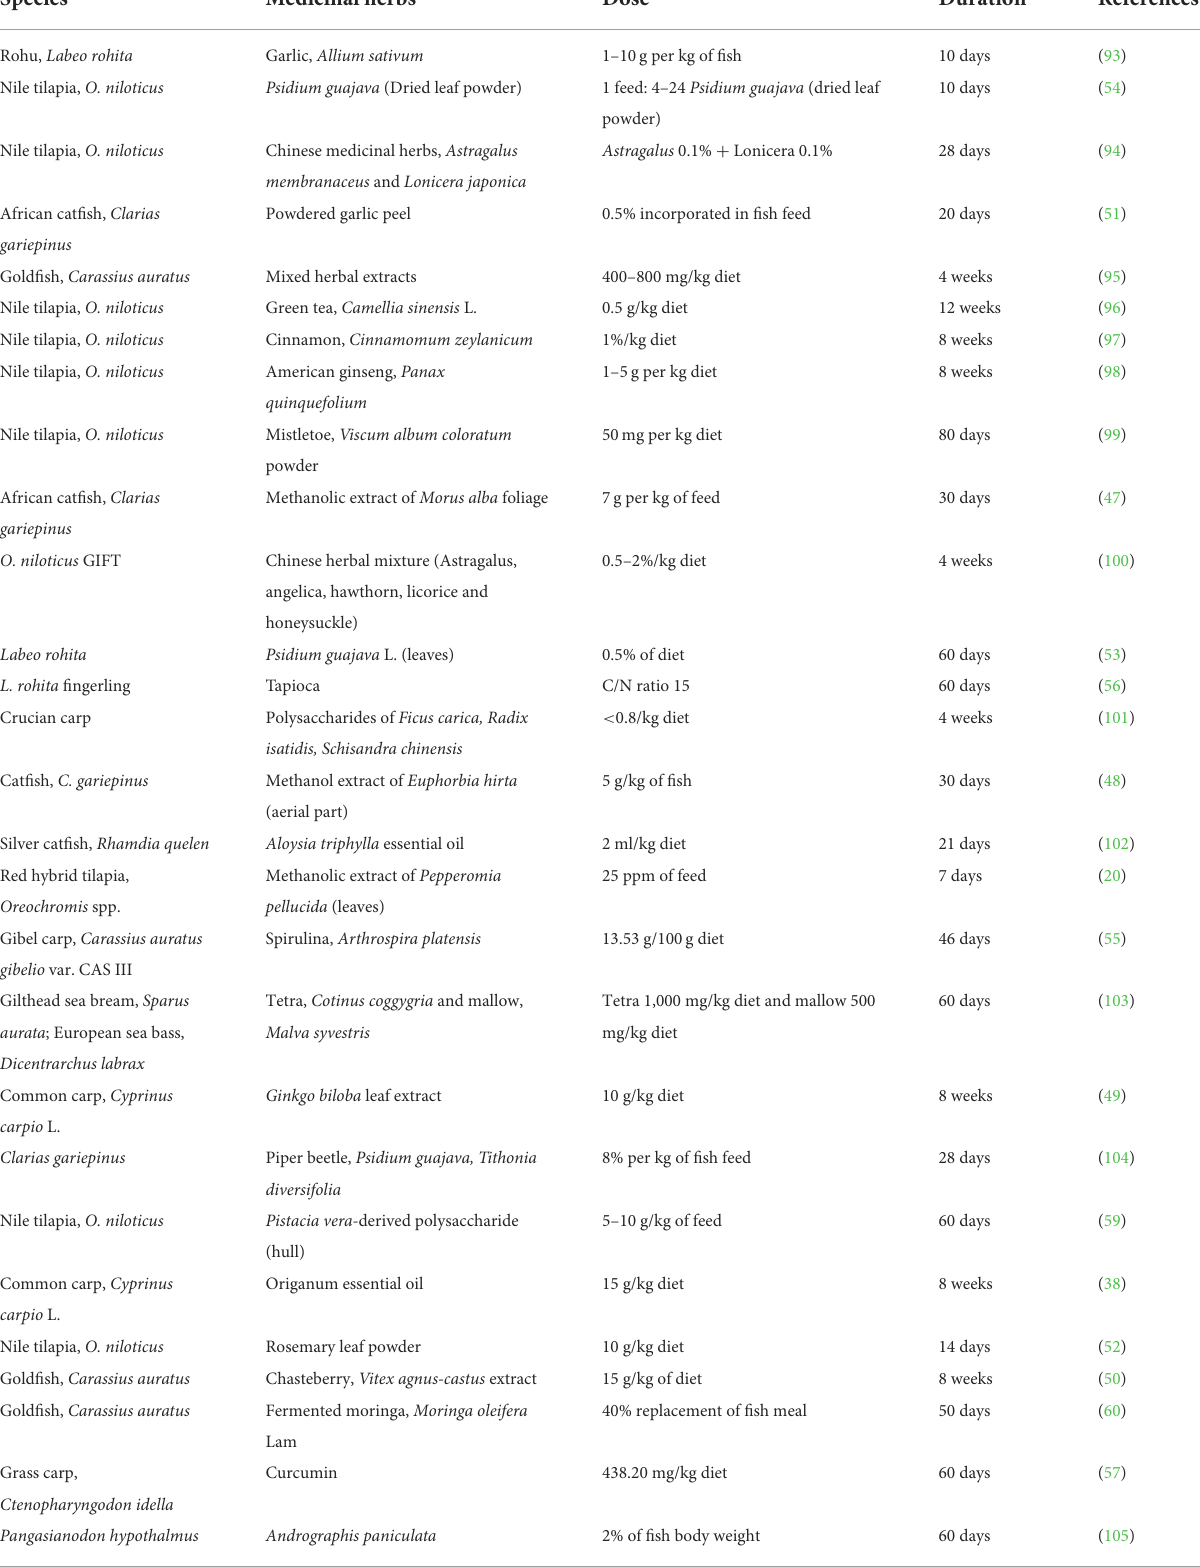
TABLE 3 Medicinal herbs used to mitigate A. hydrophila impacts on aquatic animals.